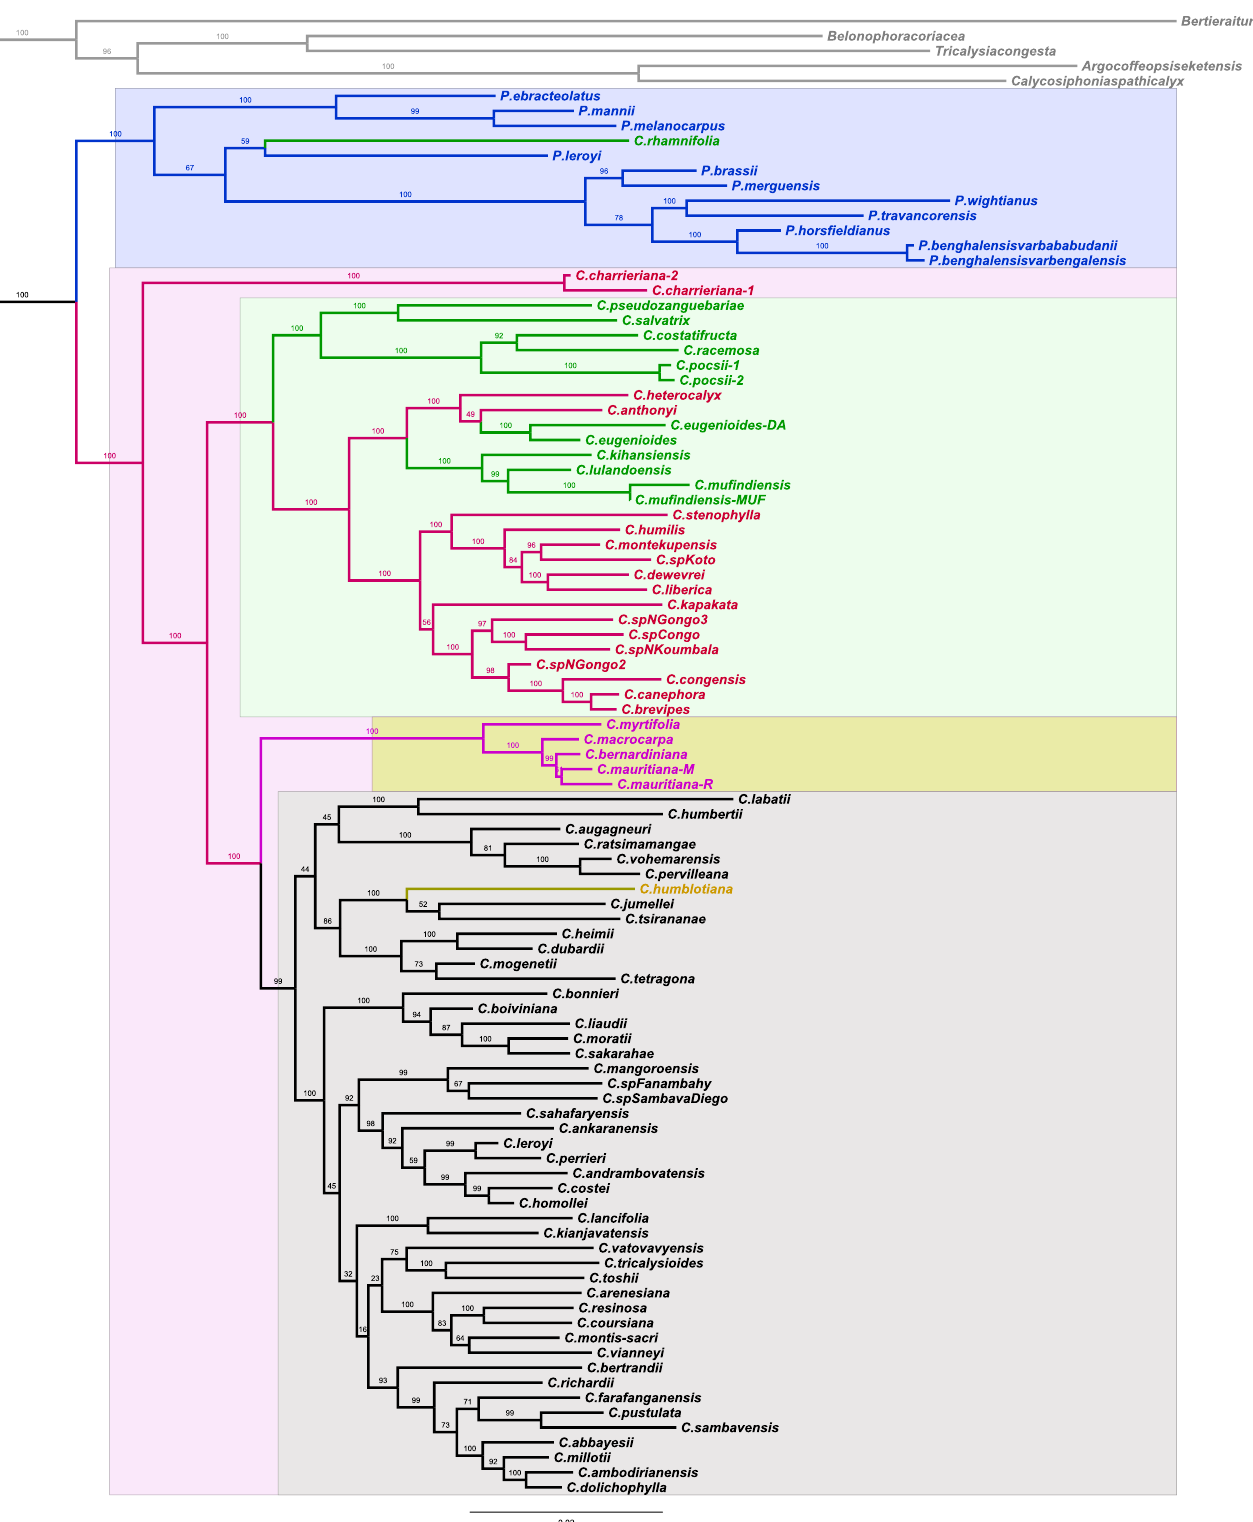
GeSeq, an efficient tool for chloroplastgenomeannotation